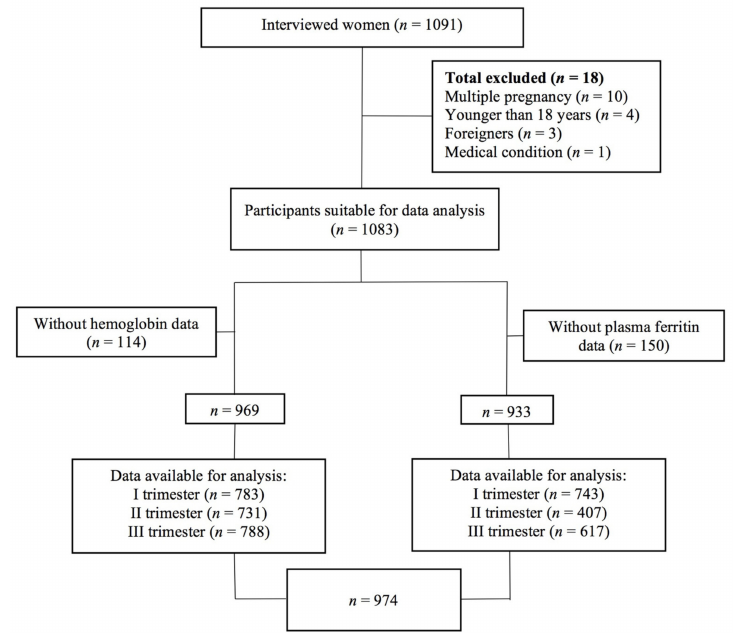
Figure 1. Schematic presentation of the sampling procedure and availability of haematologic